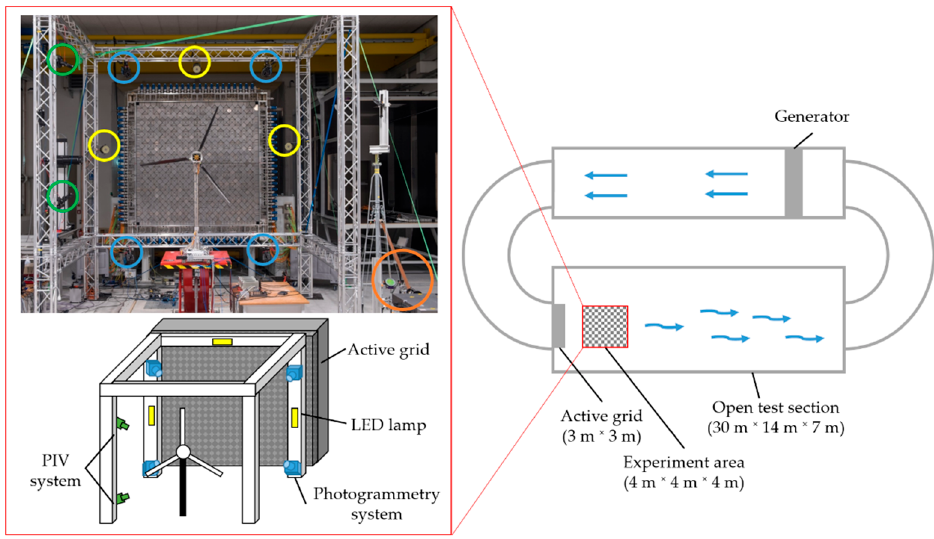
Figure 1. Experimental setup in the wind tunnel ( left ). Top view of the wind tunnel ( right ). PIV cameras are encircled in green, PIV laser in orange, photogrammetry in blue, LED lamps in yellow. The left side of Figure 1 shows the test setup for detecting fluid-structure